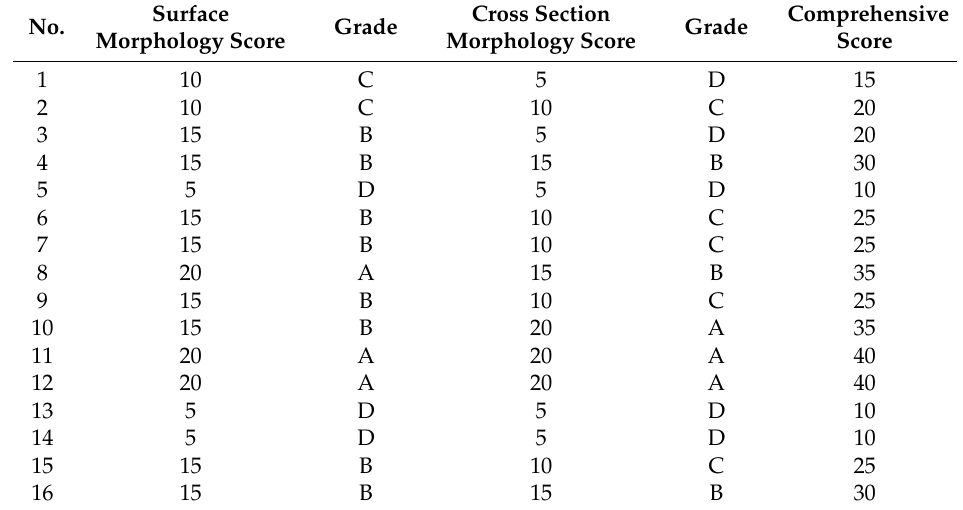
Table 5. Welding quality score results.